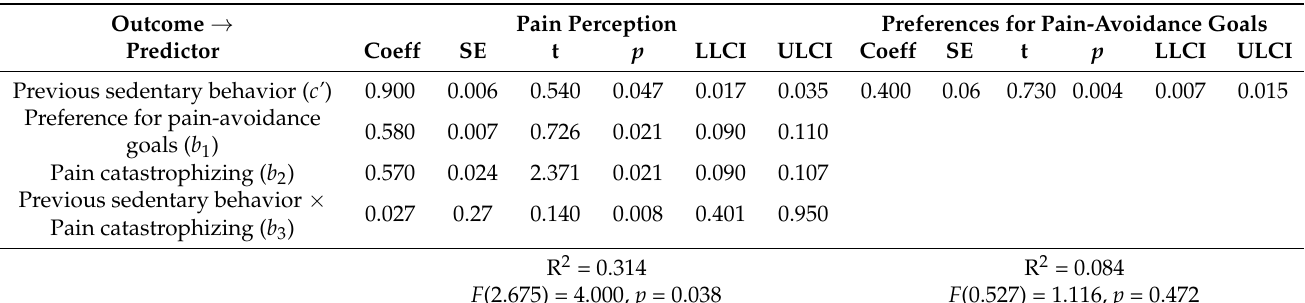
Table 3. The moderated-mediation model showed the effect of pain catastrophizing on pain percep- tion via the preference for pain-avoidance goals.